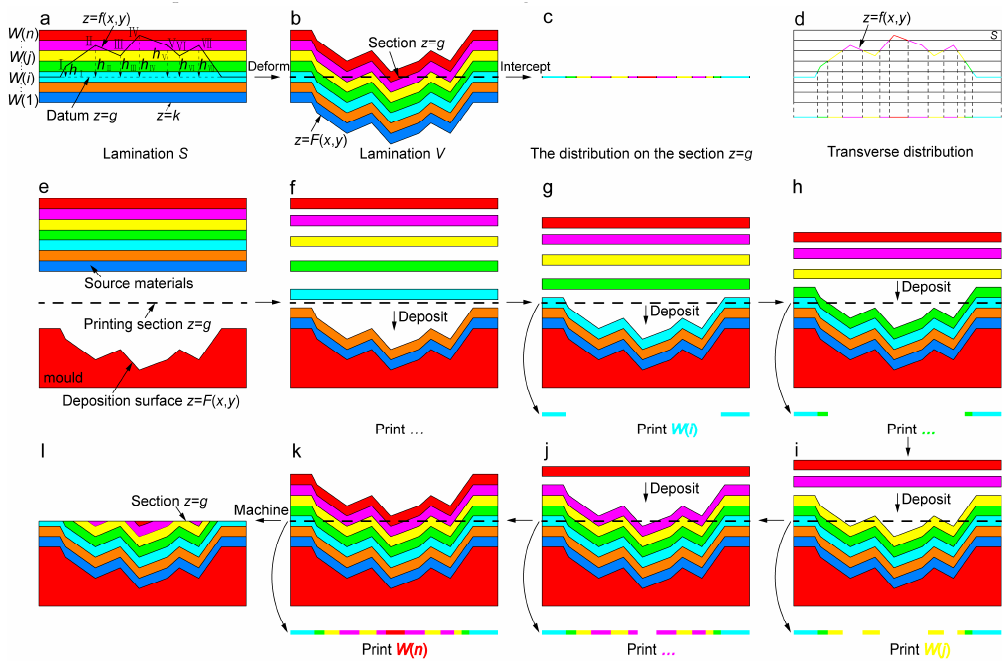
Figure 1. Three-dimensional printing strategy for arbitrary distribution of multiple materials. ( a – d ) Principle diagram of achieving arbitrary distribution of multiple materials. Arbitrary curved surface ( b ) from the surface z = f ( x , y ) to the datum z = g is implemented. For instance, the points I–VII of